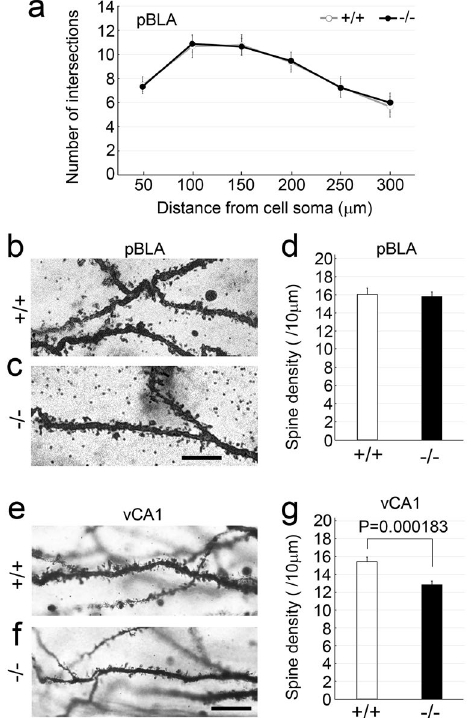
Figure 5. Morphological analyses of neurons in the Pcdh9 KO mice with Golgi staining. ( a ) Statistics of dendritic arborisation of neurons in the pBLA. The number of branches from the primary dendrite was counted with 21 neurons from two wt mice and 22 neurons from four Pcdh9 KO mice. Two-way ANOVA p = 0.76832. ( b – d ) The spine density of neurons in the pBLA was not changed in the Pcdh9 KO mice. The number of spines was counted with 31 neurons from two wt mice and 65 dendrites from four Pcdh9 KO mice. ( e – g ) Spine density in the vCA1 was significantly reduced in the Pcdh9 KO mice. The number of spines was counted with 38